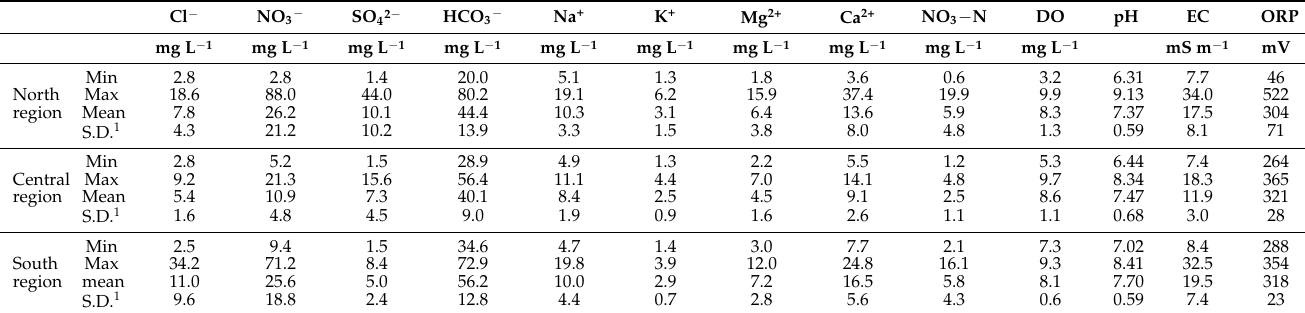
Table 1. Descriptive statistics of hydrochemical components in the three